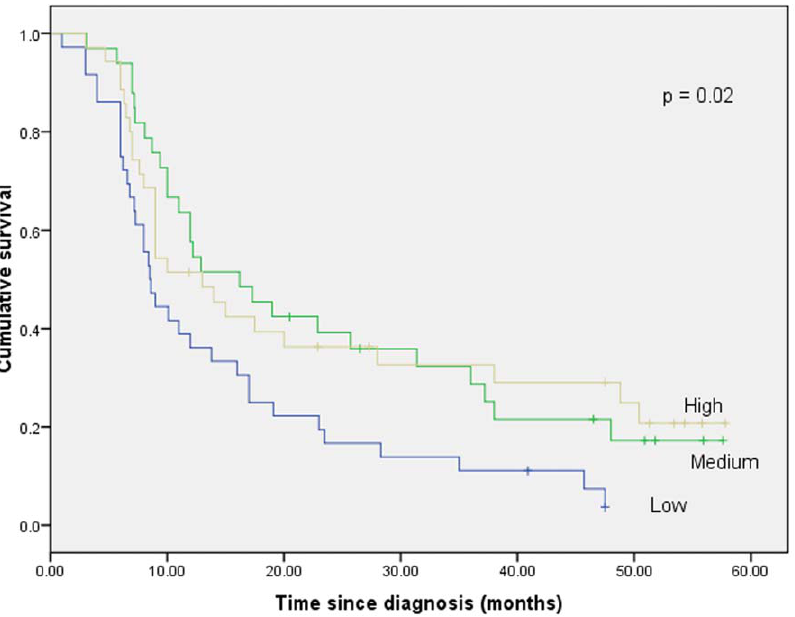
Figure 3. Cumulative survival of GC patients according to P16 (site 1) whole blood DNA methylation values.